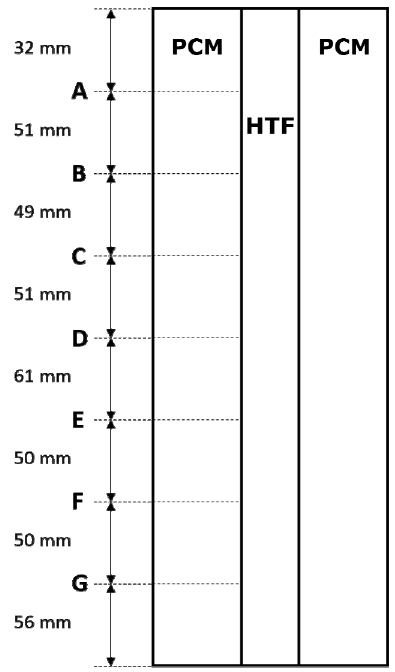
Figure 1. Basic scheme of the vertical thermocouple positioning in the phase change materials (PCM). HTF: heat transfer fluid. Table 1. Measurement point positions.